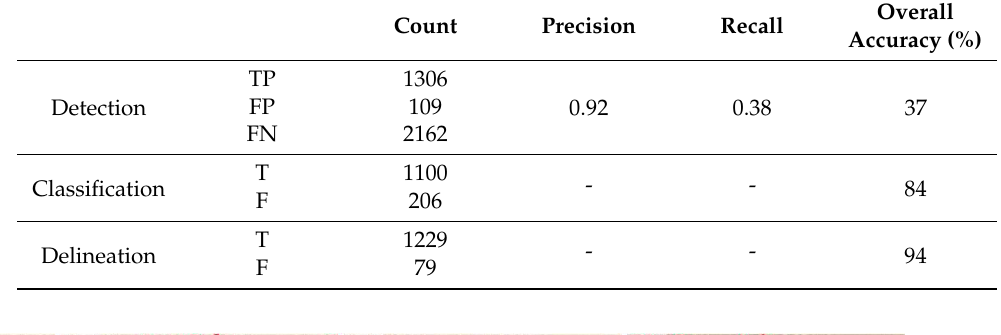
Table 4. Accuracy assessment for original images (2.0 m).